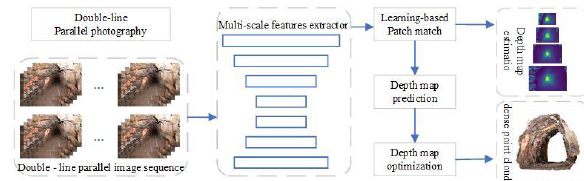
Figure 2. Flowchart of the method in this paper.